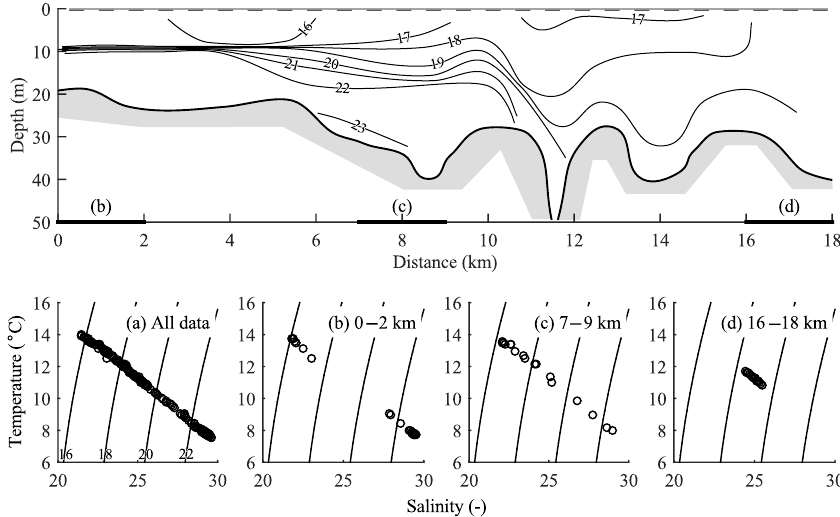
Figure 4. Along-strait transect of observations of density (minus 1000kgm − 3 ) given by contour lines (upper panel) and the distributions of salinity (in Practical Salinity Units) and temperature of the entire transect (a) , at 0–2km (b) , at 7–9km (c) , and at 16–18km (d) . In the salinity–temperature plots the lines are contours of constant density (minus 1000kgm − 3 ). The observations were made using a ScanFish (see text) with the entire transect corresponding to 15 undulations. The transect was made on 16 June 2004 from 12:22 to 13:37UTC along the short survey line as shown in Fig.